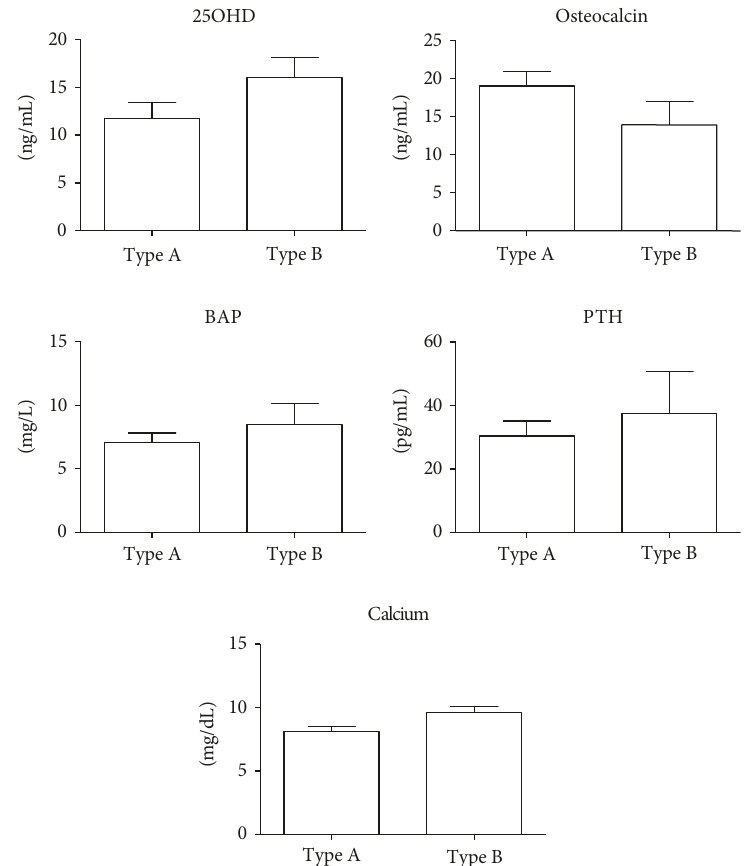
Figure 2: Evaluation of 25OHD, osteocalcin, bone alkaline phosphatase (BAP), parathormone (PTH), and calcium levels in patients with acute aortic dissection (AAD) classi fi ed according to dissection localization: types A and type